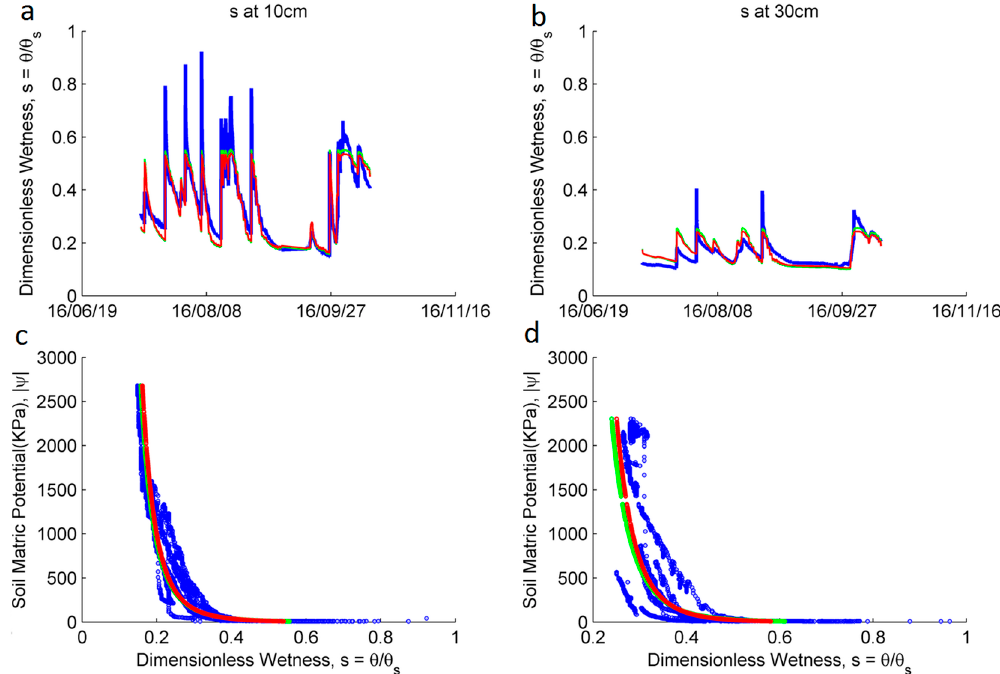
Figure 8. Estimation of the soil hydraulic parameters from data at the location close to the middle of the hill in site 2 (i.e., Nodes 2282 and 2292, and data logger DL2). Wetness, s , in blue; Estimated wetness from measured matric water potential (WP) using the Clapp and Hornberger, and van Genuchten equations, in green and red, respectively. ( a ) Comparison of the wetness, s , time series, at a depth of 10 cm; ( b ) Same as part a, for a depth of 30 cm; ( c ) Relationship between the soil wetness, s , and the absolute value of the WP, in kPa, | ψ | at a depth of 10 cm. The fitted Clapp and Hornberger equation is shown in green and the fitted van Genuchten equation in red; ( d ) Same as part c, for a depth of 30 cm. Table 1. Soil parameter calibration results for the Clapp and Hornberger, and Van Genuchten PTFs.